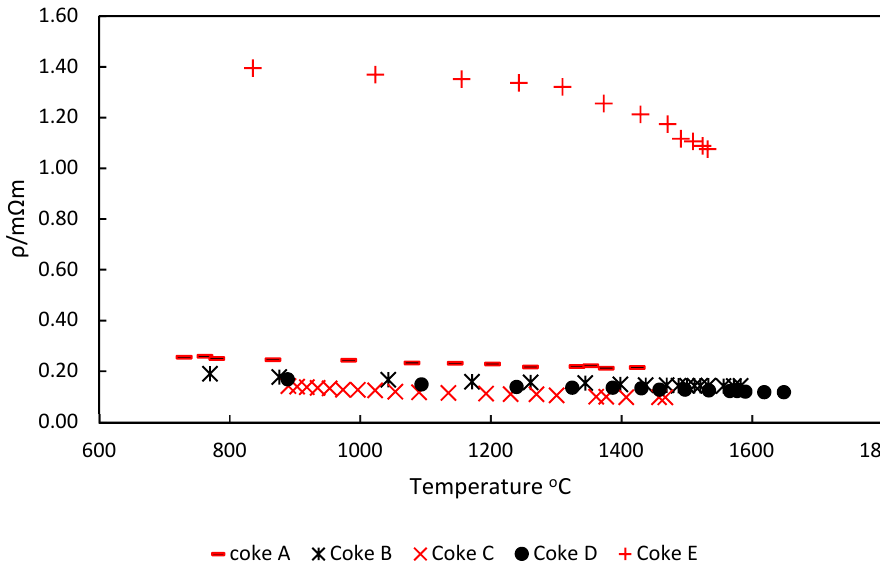
Figure 6. Change in coke resistivity with increasing temperature.